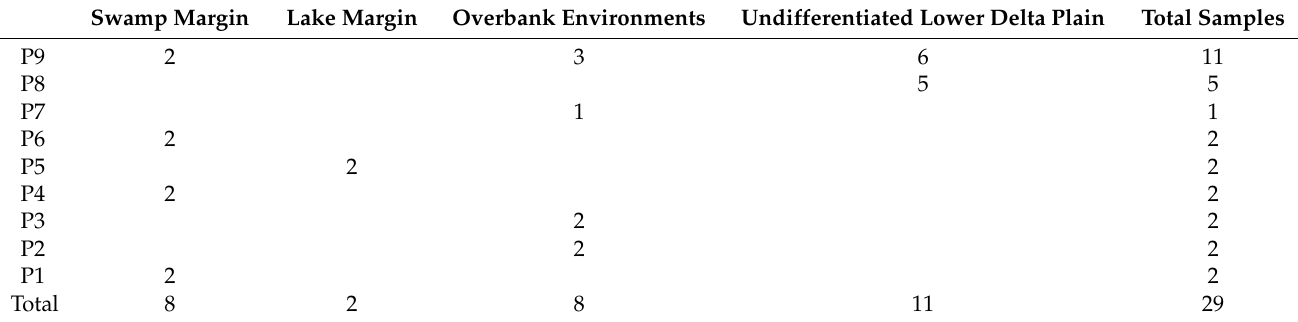
Table 1. Number of samples in each examined paleosol horizon and depositional environment. Swamp